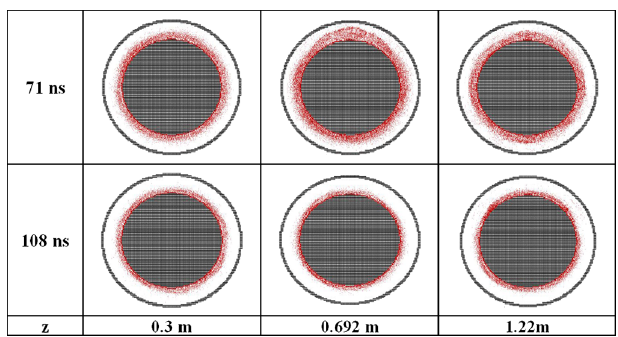
FIG. 15. Electron phase space matrix in the XY plane at differ- ent positions. The X axis lays in the horizontal, and Y axis in the vertical. The outer circles represent anodes, and inner circles represent cathodes. The helical support is at the top of the A-K gap and z ¼ 0 : 496 m . As can be seen, even at the rise edge of current ( t ¼ 71 ns ), the influence of support to electron flow is weak and electron flow can recover in a short distance. At the moment close to maximum ( t ¼ 108 ns ), phase space for the three different positions is almost the